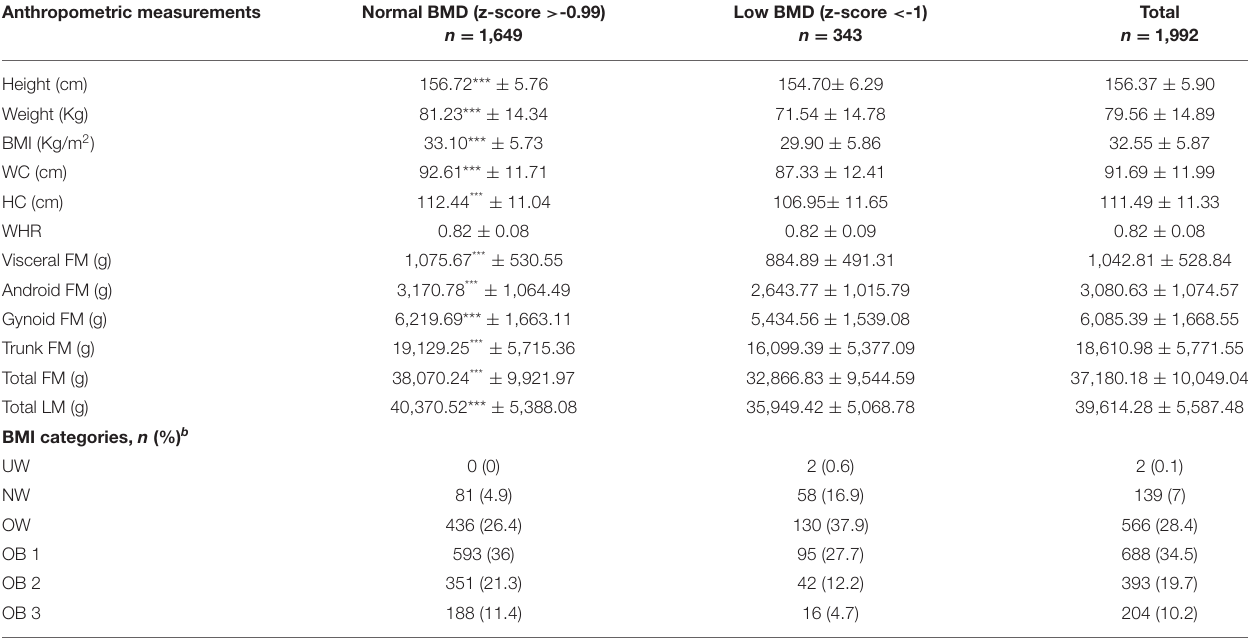
TABLE 2 | Anthropometric measurements according to BMD category a . Anthropometric